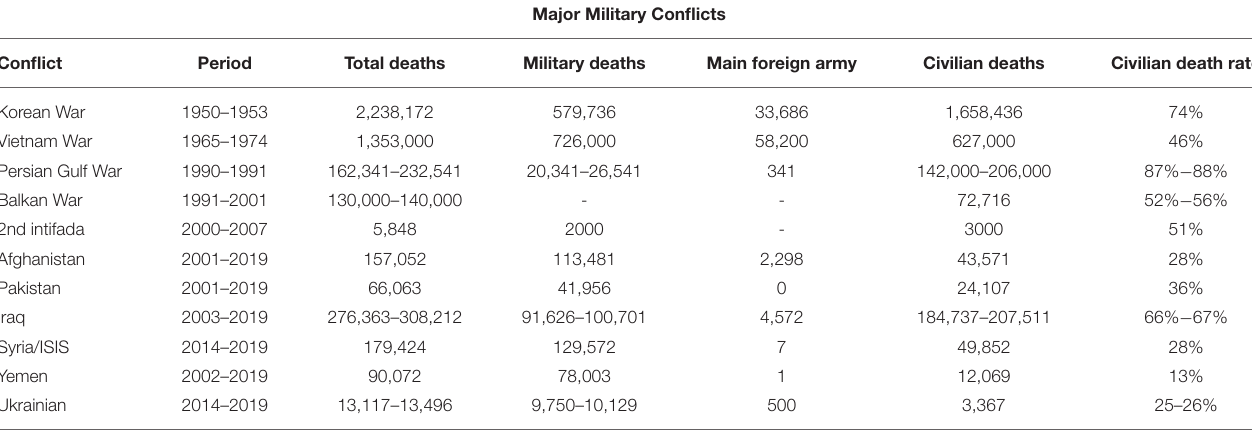
TABLE 1 | The outcome of wars/conflicts in terms of mortality.